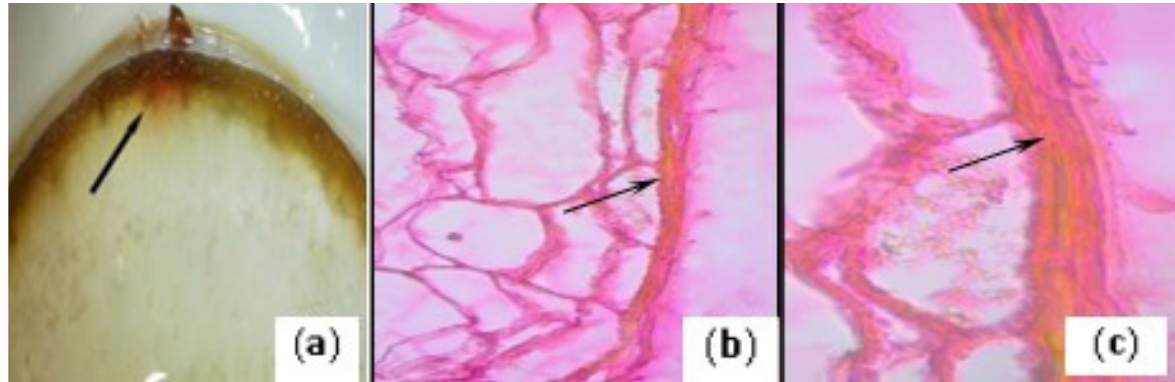
Figure 1. Grape sections after being immersed in the alkaline solution. The phenolphthalein turned bright magenta immediately on contact with the alkaline solution: (a) arrow pointing grape skin 32 x magnification microscopy, (b) arrow pointing grape skin 400 x magnification microscopy, (c) arrow pointing grape skin 1000 x magnification microscopy.